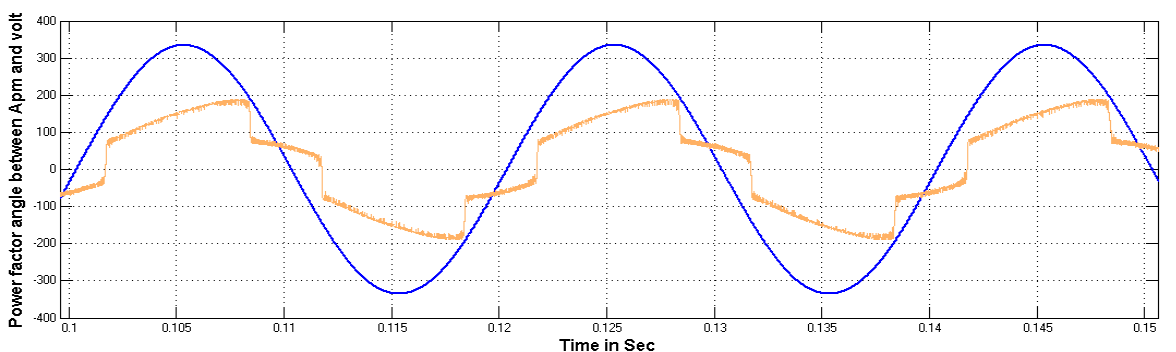
Figure 29. Source current and voltage phase angle